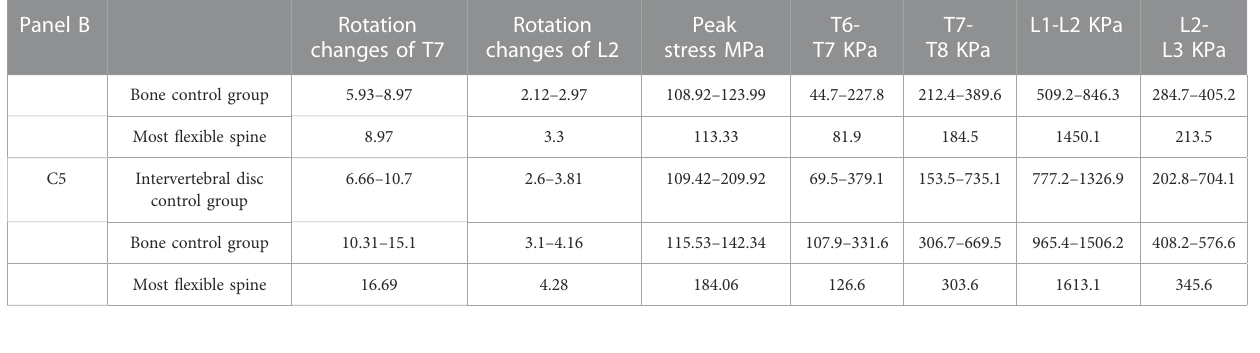
TABLE 4 ( Continued ) Spinal parameters under different force con fi gurations and magnitudes.